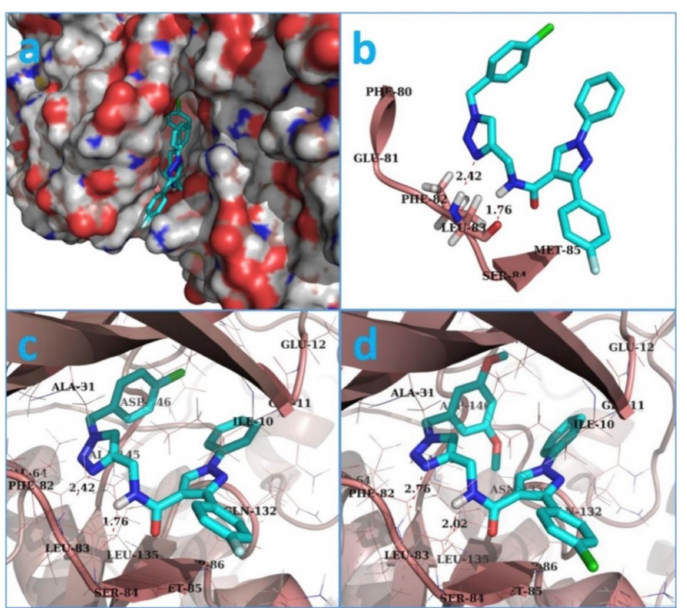
Figure 28. Putative bind interactions of compounds 20 ( a – c ) and 21 ( d )